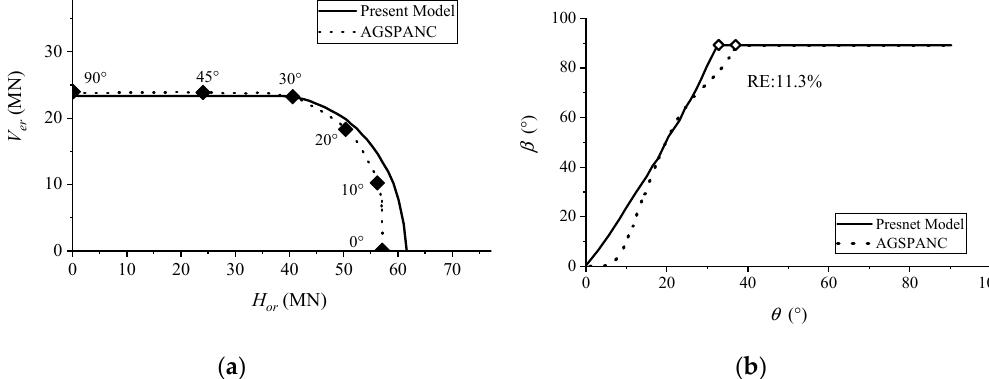
Figure 7. Comparative results of the numerical analysis conducted by Randolph and House [35,43]: ( a ) Pullout capacities in horizontal and vertical planes; ( b ) Failure angle.